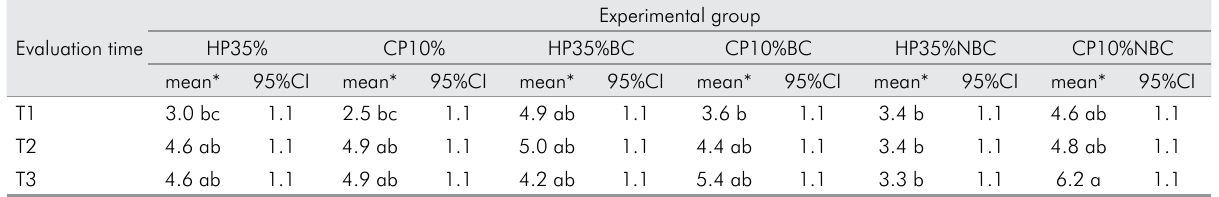
Table 2. Mean and Confidence interval (95%CI) for color alteration (∆E) for each experimental group at each evaluation time. Evaluation time